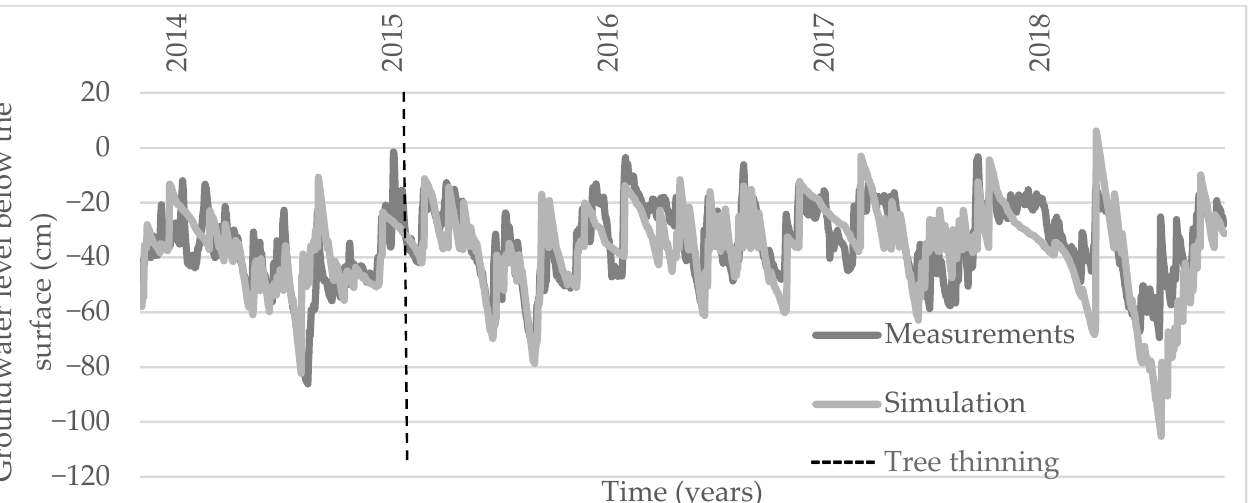
Figure 6. Measured vs. simulated groundwater level in plot 3.